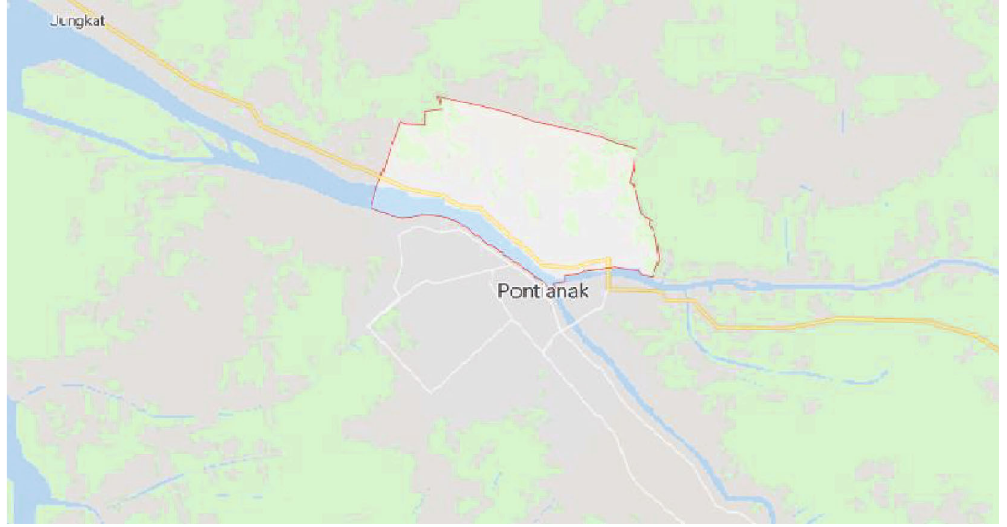
Figure 1: Research location